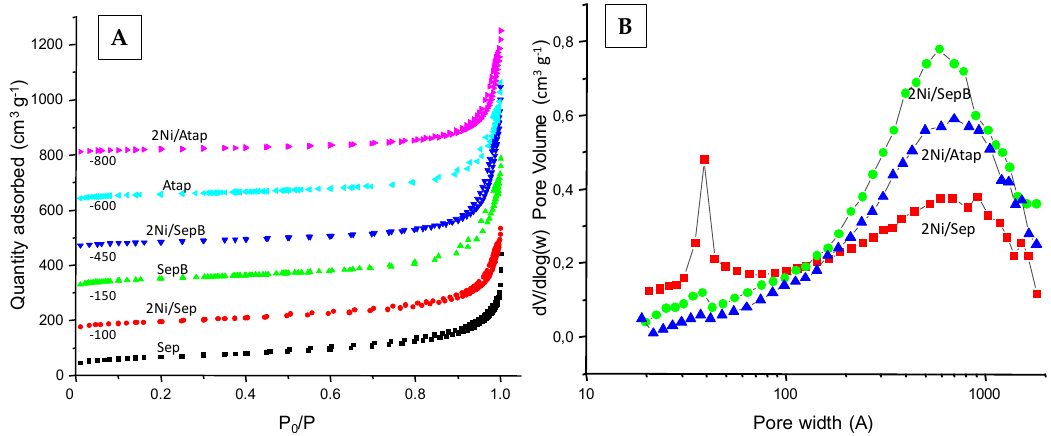
Figure 3. N 2 isotherms patterns for the catalysts with 2 wt.% Ni supported on different materials ( A ) and representative pore distributions ( B ).